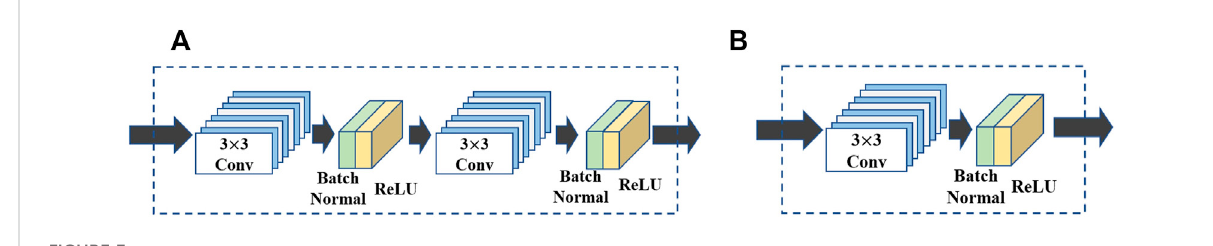
FIGURE 3 CNN Block structure (A) Based on ResBlock and Shortcut bypass deletion (B) Typical CNN